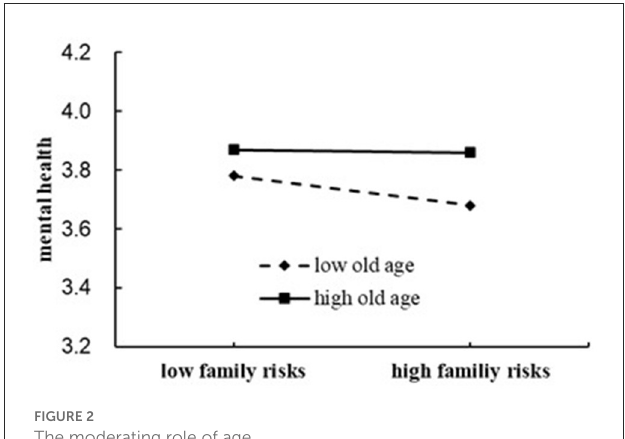
FIGURE2 The moderating role of